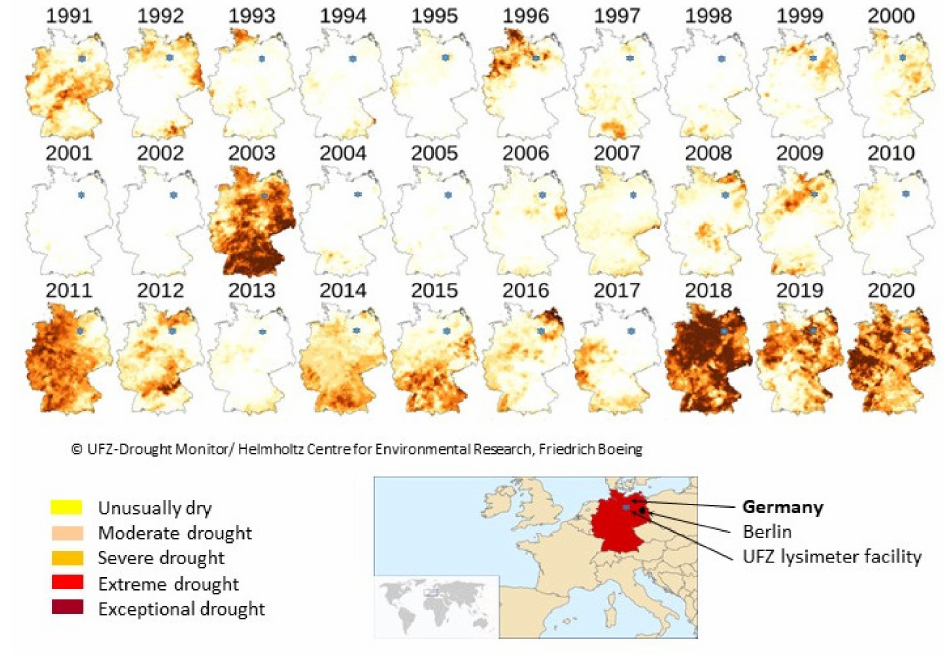
Figure 3. UFZ Drought Monitor—Drought magnitudes in the topsoil in the growing season April to October and location of the study area (the circles indicate the location of the UFZ lysimeter facility).